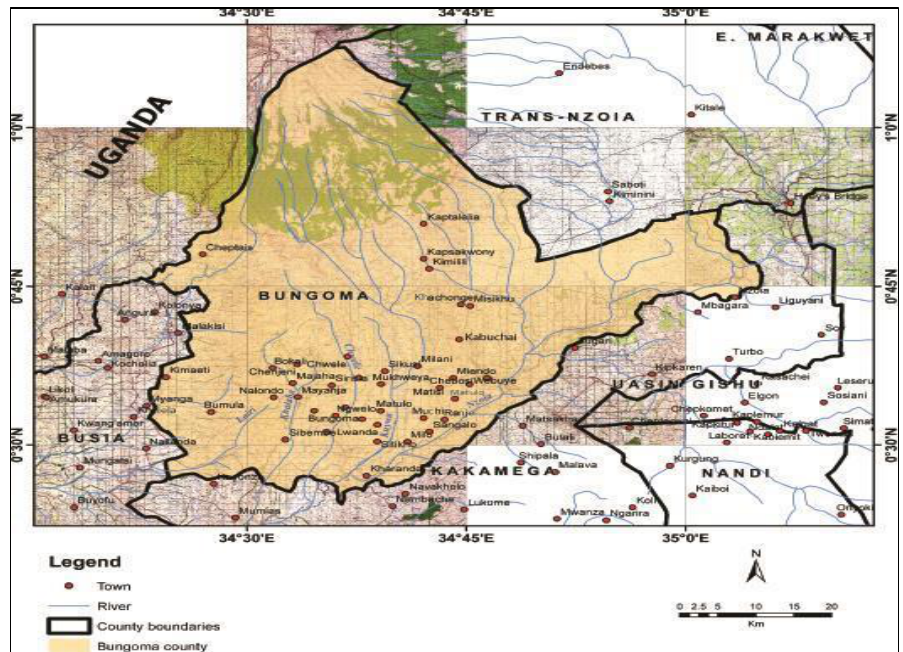
Figure 1: The map of Bungoma county showing distribution of